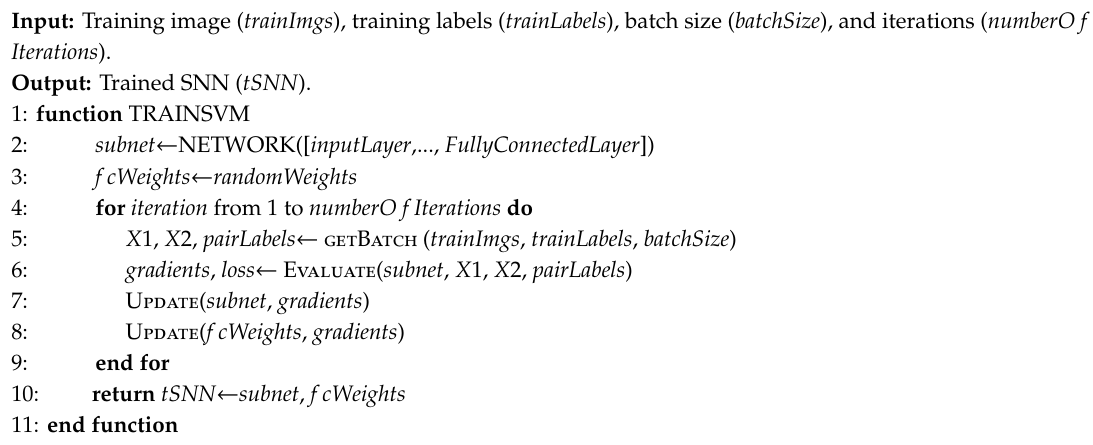
Algorithm 3. Siamese training